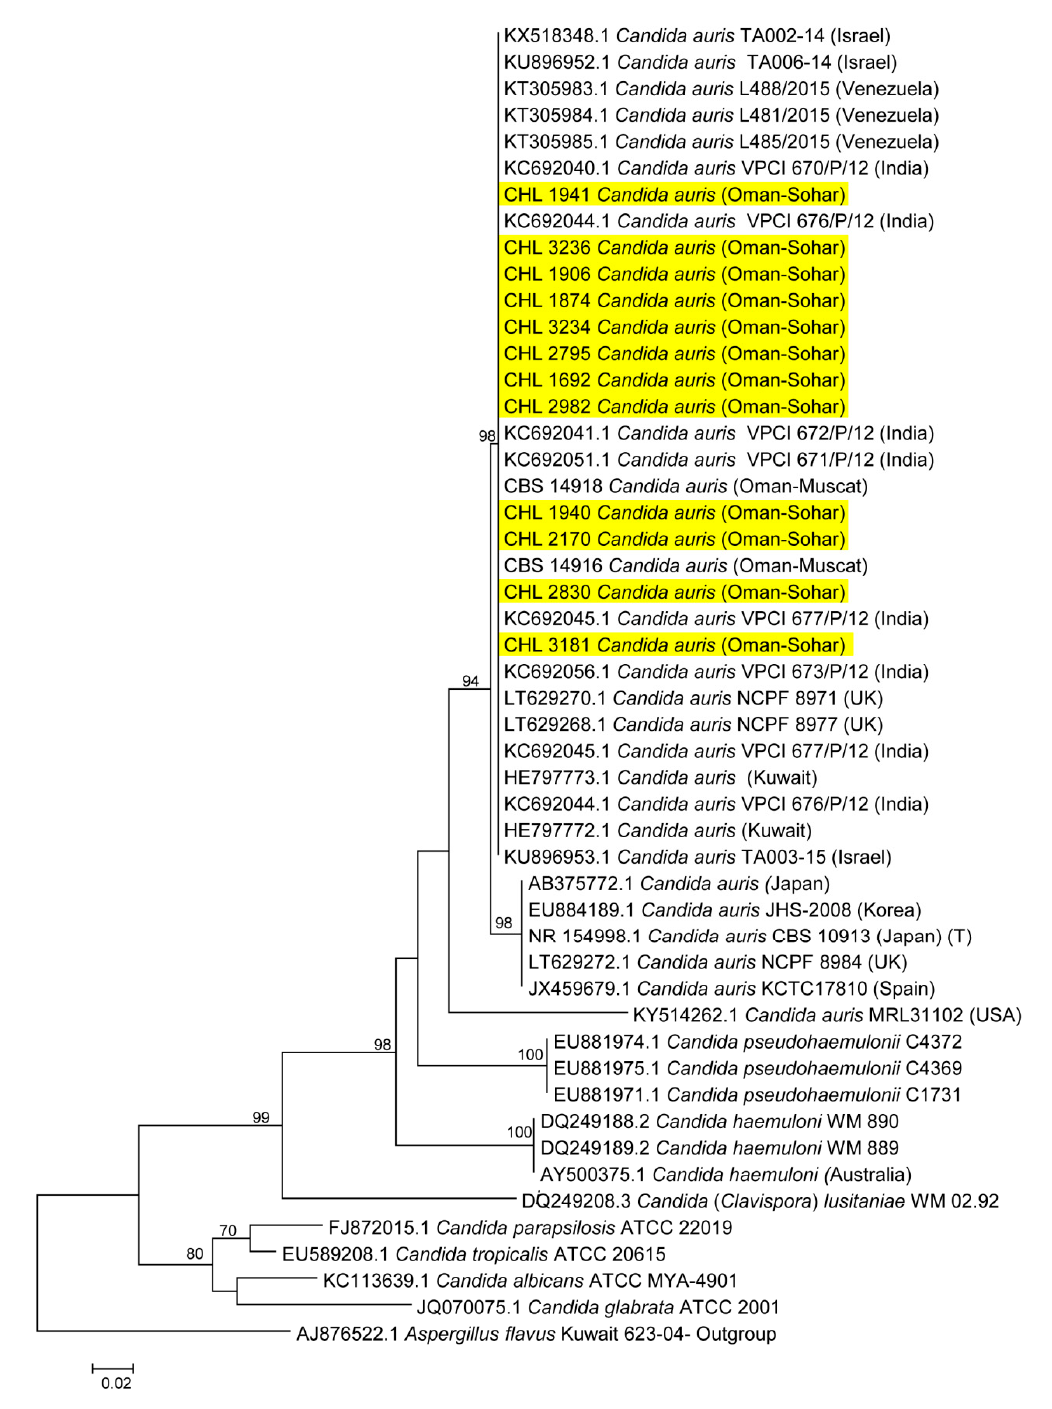
Figure 3. Phylogenetic tree generated by MLH analysis using ITS sequences of the C. auris strains with closely related Candida species. Bootstrap-supported values above 70% are indicated at the nodes. Yellow color indicates C. auris strains examined in this study from Oman.